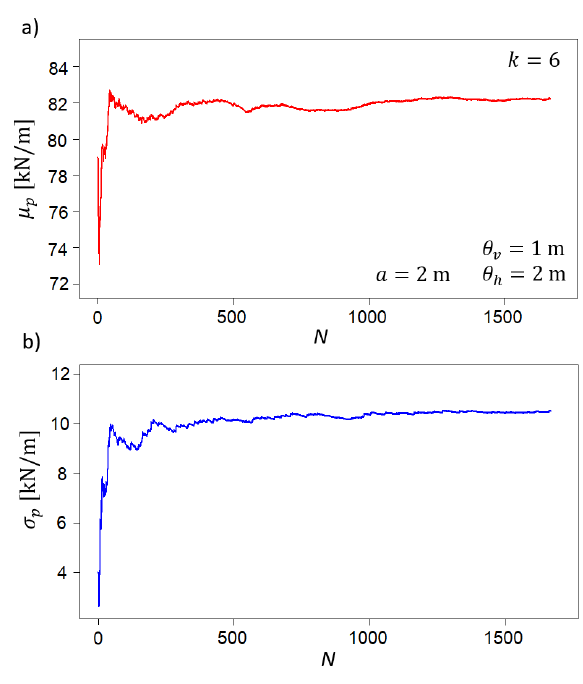
Figure 10: Stabilisation of bearing capacity mean values (a) and standard deviations (b) for the iterative approache for k